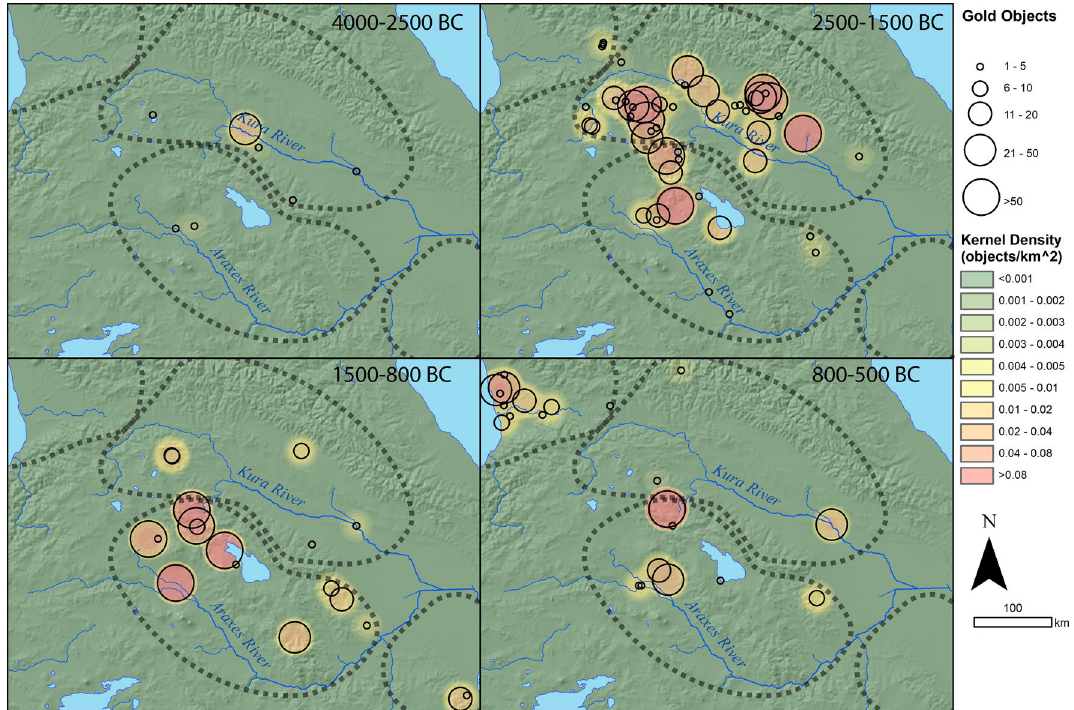
Figure 3. Spatial map of gold use over time. Black circles marking site locations, scaled to the number of gold objects, are overlain over a kernel density raster illustrating areas of high densities of gold objects. Dashed lines correspond to geographic zones in Figs. 1 and